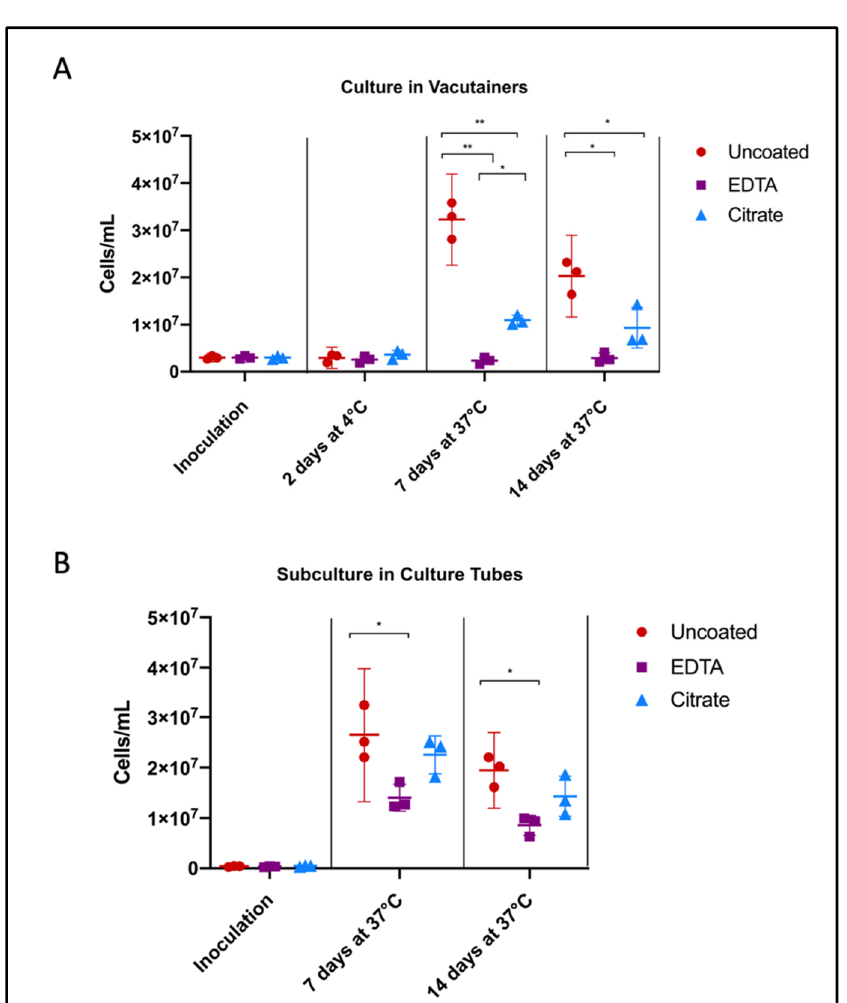
Figure 2. Influence of anticoagulants on Borrelia cultivability. To consider anticoagulant impact on Borrelia culture growth, we performed cell counts following inoculation of Borrelia into BSK broth and incubation in uncoated, EDTA, and citrate vacutainers, monitoring ( A ) the direct effects of anticoagulants on pathogen growth, and ( B ) consequences upon subcultivation. Culture was aliquoted into fresh BSK in an uncoated culture tube after 48 h in vacutainers (from A), to mimic standard shipping and laboratory culture procedure. Horizontal lines represent mean of three biological replicates and whiskers display the standard deviation. Asterisks indicate a significant difference (* = p < 0.05, ** = p < 0.0001) by one-way ANOVA and Tukey’s multiple comparisons post-hoc test ( n = 3).